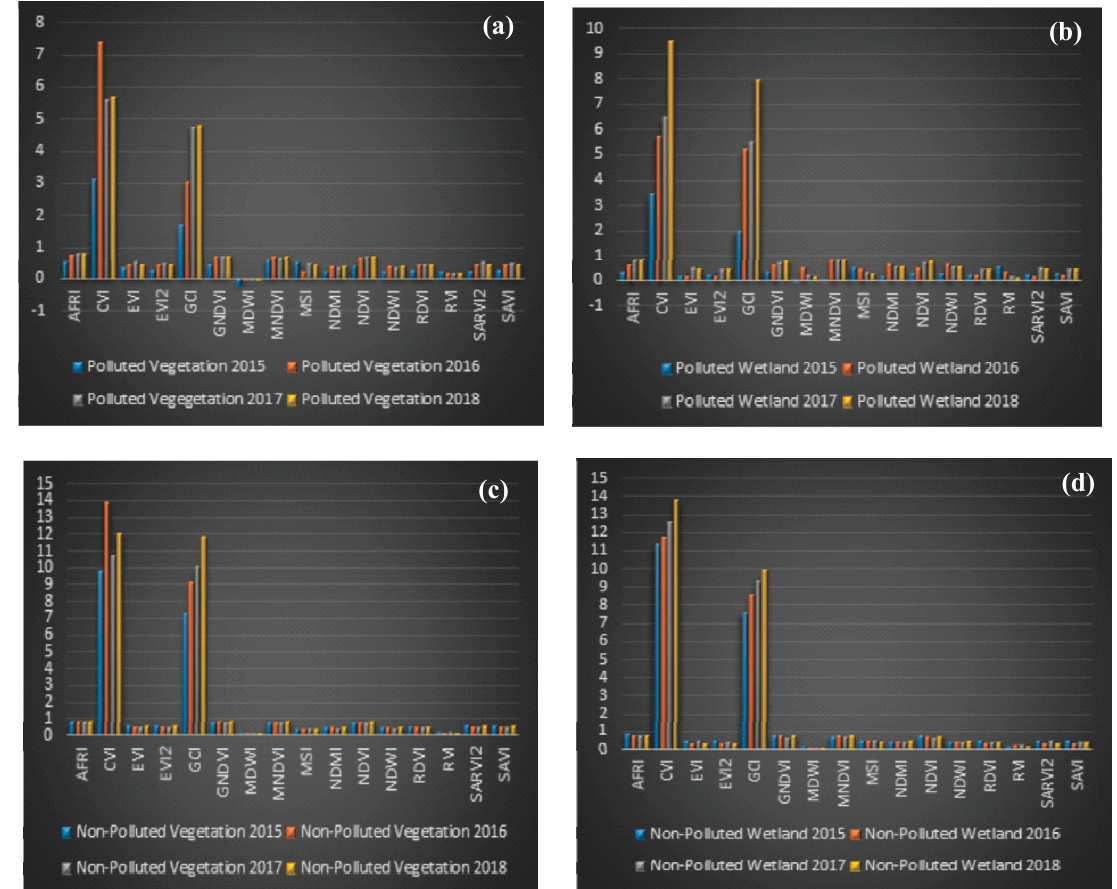
Figure 7. ( a ) Polluted vegetation recovery 2015–2018; ( b ) Polluted wetland recovery 2015–2018; ( c ) Nonpolluted vegetation status 2015–2018; ( d ) Nonpolluted wetland status 2015-2018.